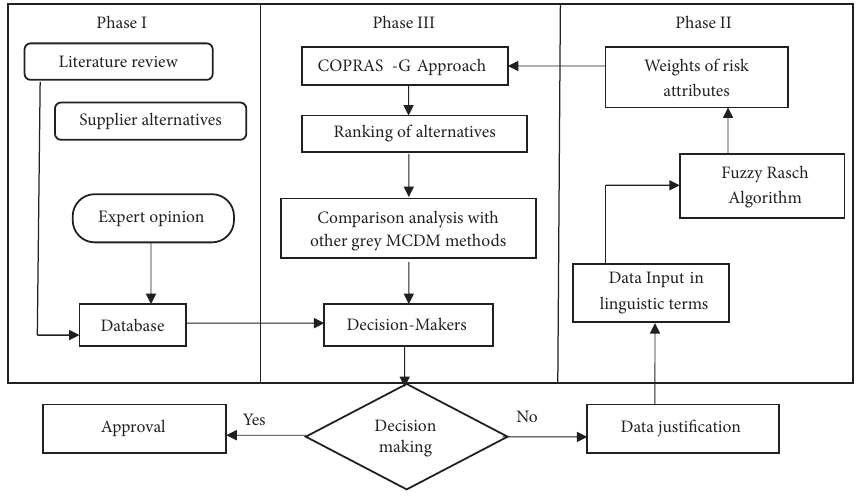
Figure 3. Outline for proposed hybrid model of fuzzy Rasch and COPRAS-G for decision